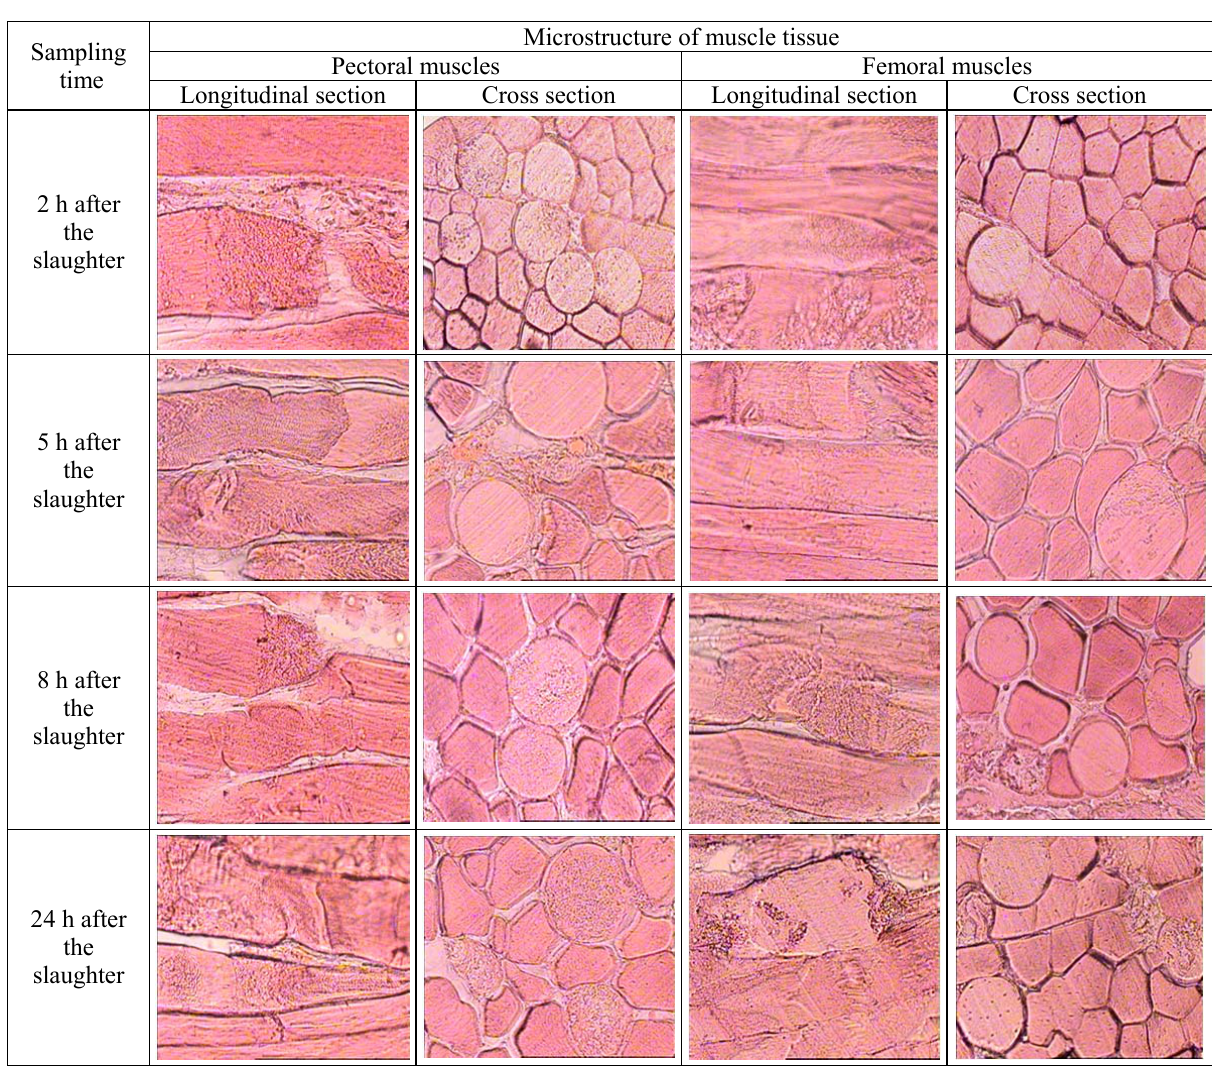
Table 3 . Microstructure of the muscular tissue of turkey meat at different stages of autolysis with its history characteristic of meat with the pronounced symptoms of